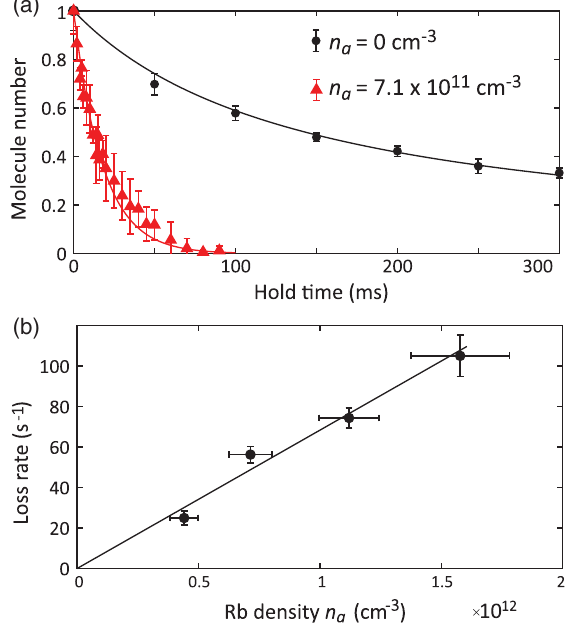
FIG. 2. Two-body collisional loss in an ultracold mixture of KRb molecules and Rb atoms. (a) Normalized molecule number versus hold time for a pure molecular sample (black circles) and for a representative atom-molecule mixture (red triangles). Each data point is an average of 10 repetitions. Error bars represent the standard error of the mean, the black solid line is a fit to the two-body decay arising from molecule-molecule collisions [12], and the red solid line is a fit using the function ð t Þ ¼ exp ð − k N n t Þ . (b) Dependence of the molecular loss m m;a a rate on the atomic density. A linear fit (black solid line) yields ¼ 6 . 8 ð 7 Þ × 10 − 11 cm 3 s − 1 , which is consistent with the k m;a predicted universal loss rate [44]. Vertical and horizontal error bars represent the 1 σ statistical uncertainty in the measured loss rate and in the calibrated value of n , respectively. All data shown a in (a) and (b) are taken with B ¼ 542 G in a continuously ¼ 11 . 3 kW = cm 2 operated ODT of intensity I tot